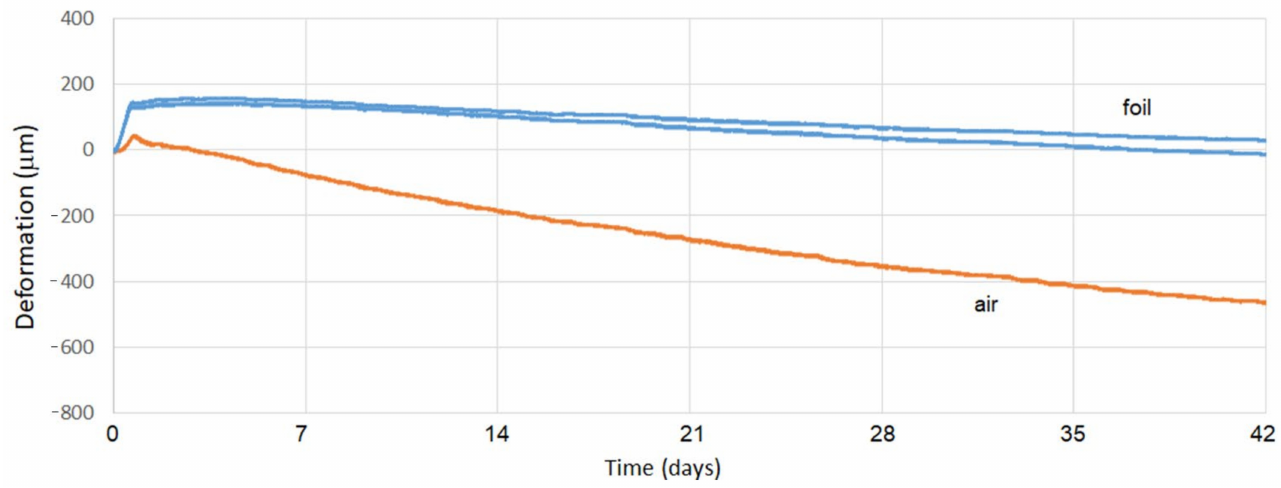
Figure 17. Volume changes of fiber-reinforced concrete over 42